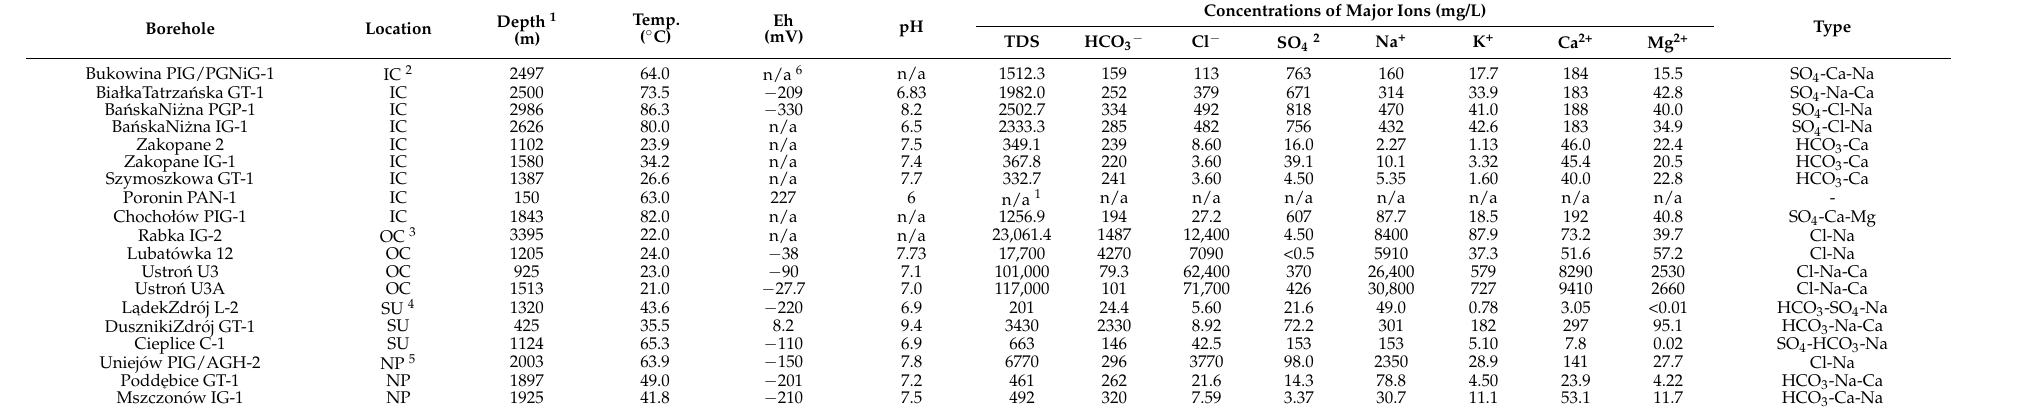
Table 1. The physical parameters and chemical composition of the Polish thermal waters investigated.